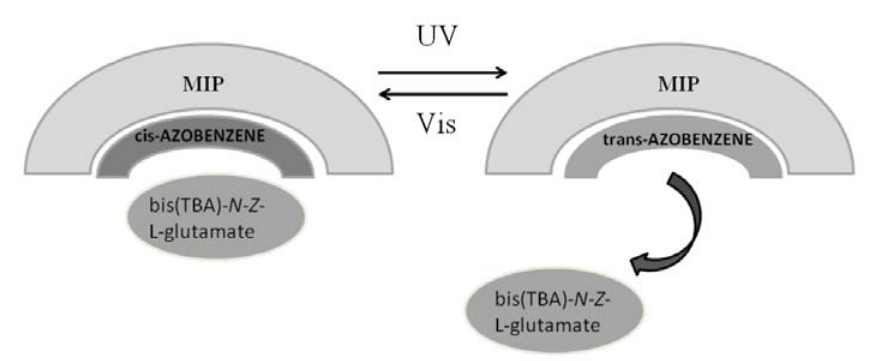
Figure 21. Schematic photo-regulated release and uptake of bis(TBA)- N - Z - L -glutamate.